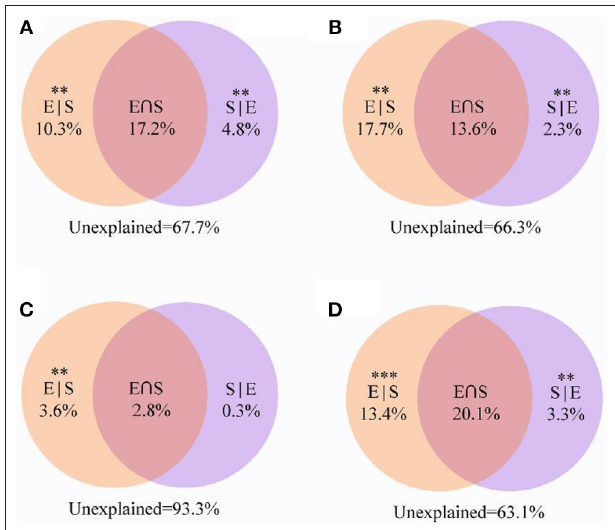
FIGURE 7 | Variation partitioning analysis showing the percentages of variance in soil bacterial communities explained by environmental factors and spatial distance. (A) All; (B) Generalists; (C) Specialists; (D) Other taxa. The variation explained by pure spatial and environmental factors corresponds to the bacterial community without the effect of the other by ANOVA permutation tests. ** P < 0.01 and *** P < 0.001. S|E pure spatial variation, E|S pure environmental variation, S T E share explained variation, 1-S|E- E|S-S T E unexplained